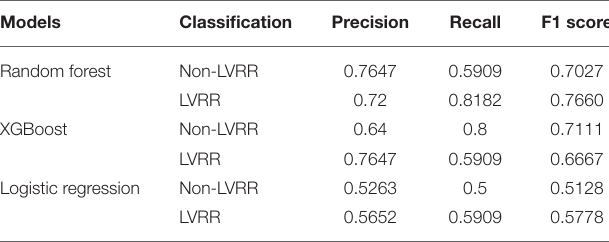
TABLE 2 | Comparison of model performance.